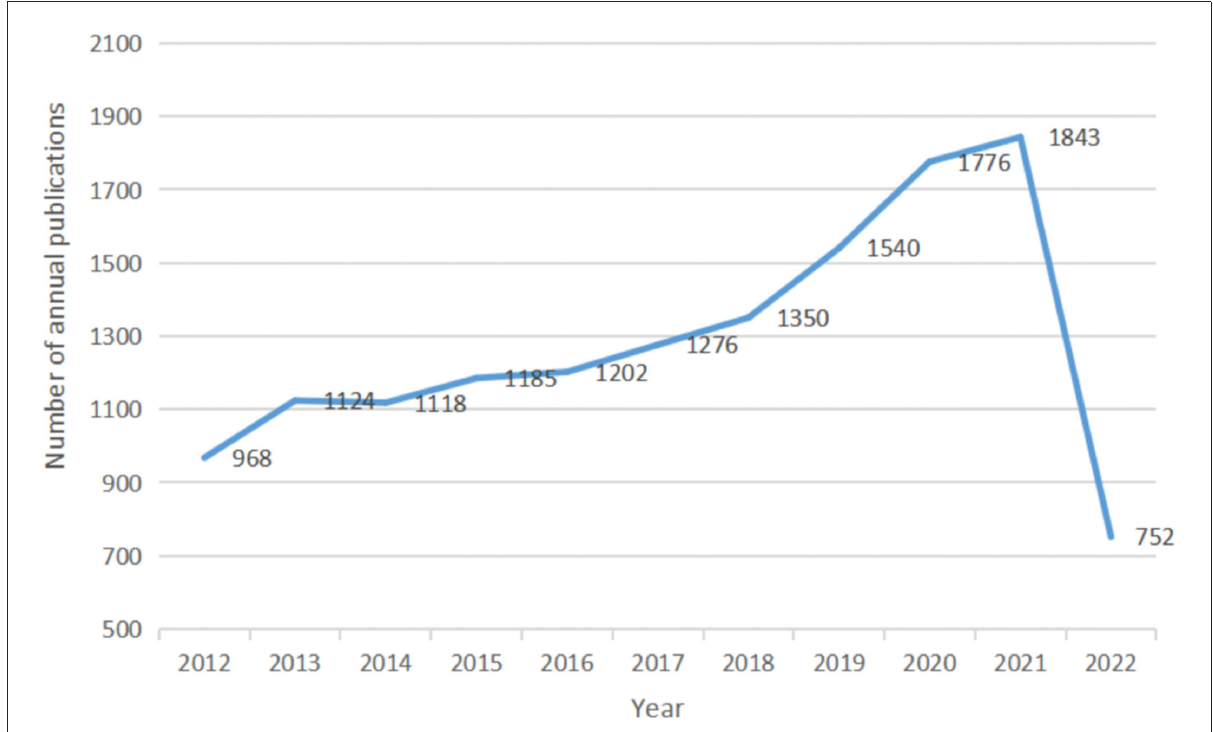
FIGURE2 The number of articles related to dysphagia published annually from 2012 to